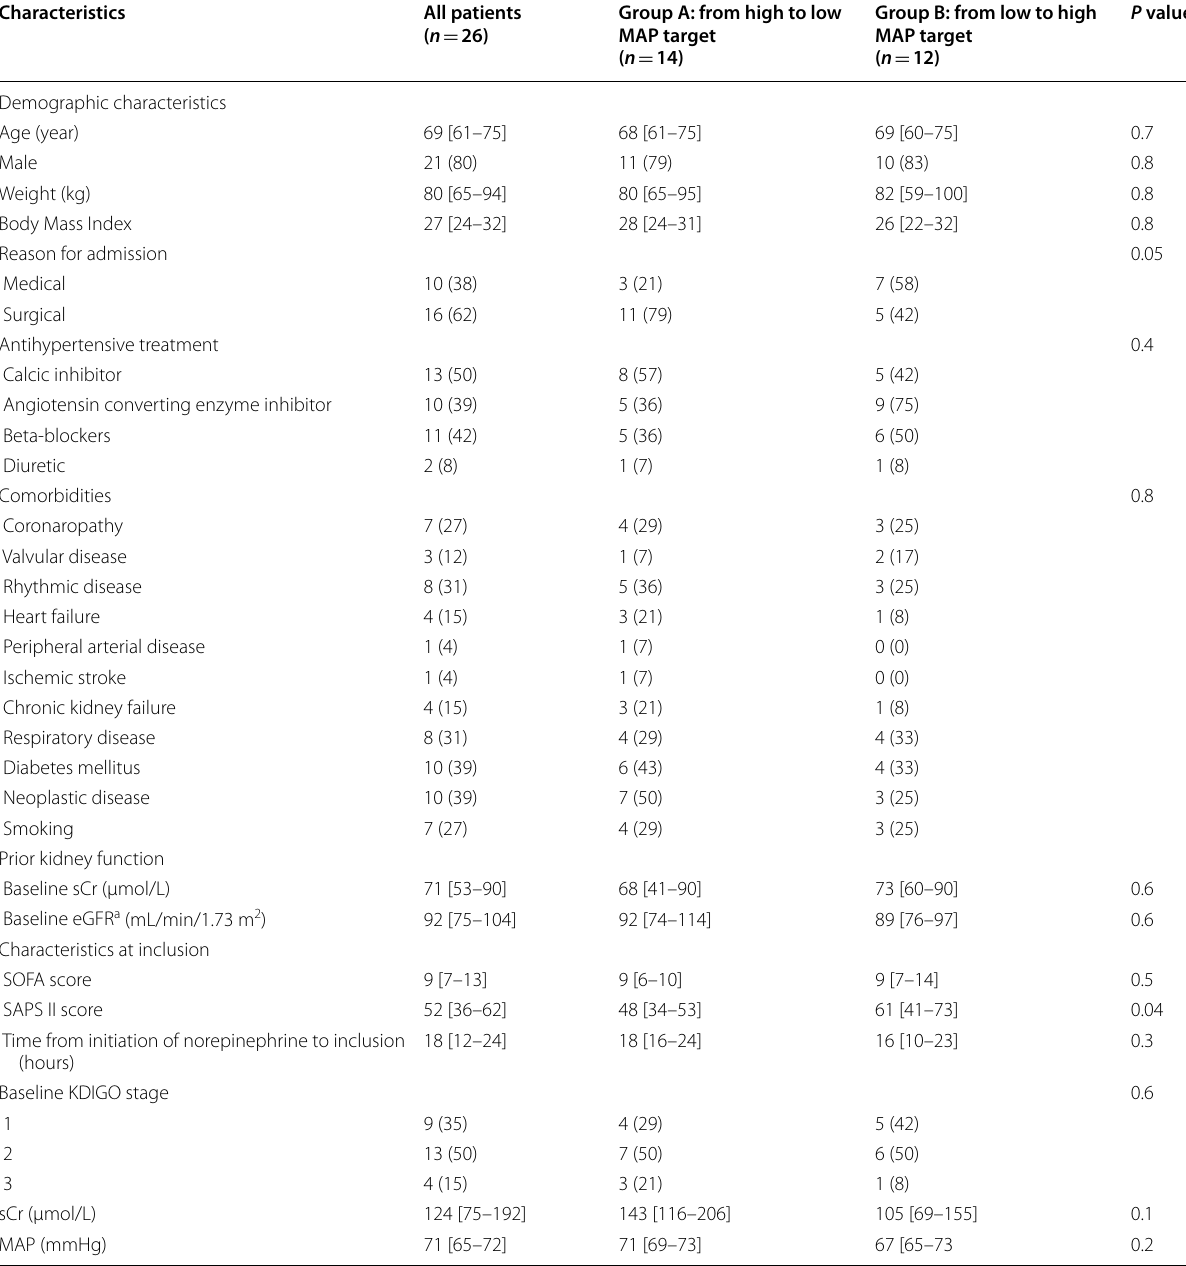
Table 1 Baseline characteristics of patients ( n